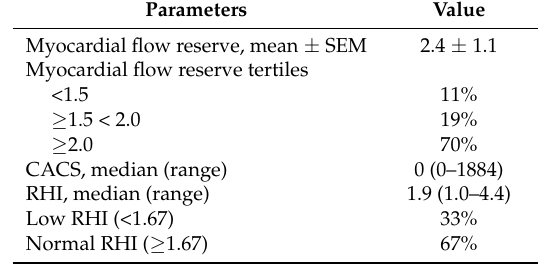
Table 3. Data from the original 82 -rubidium study and the RHI from the present endoPAT ® study.